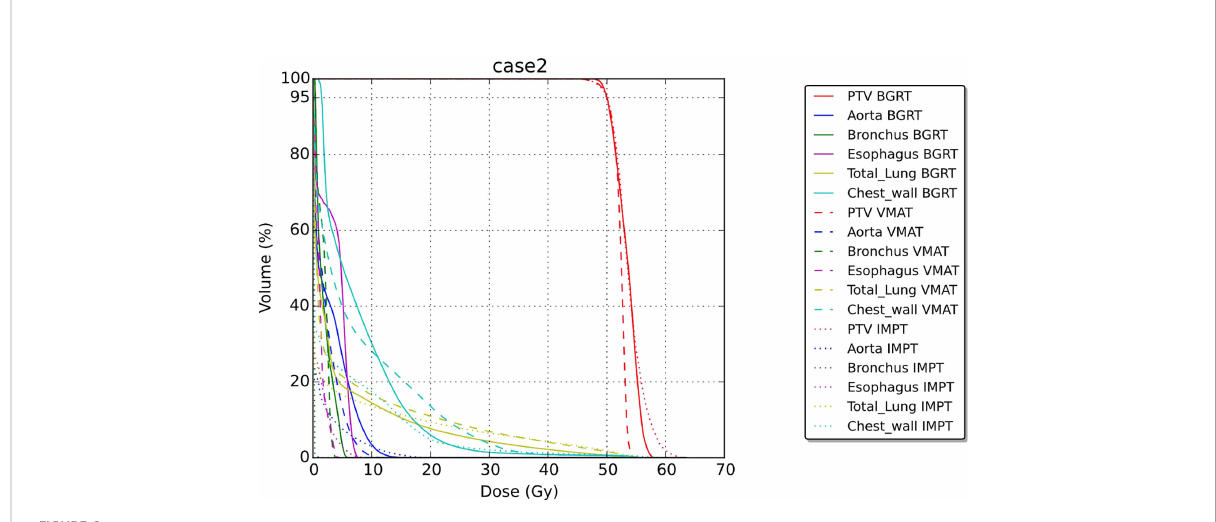
FIGURE 6 Dose – volume histogram for case 2.